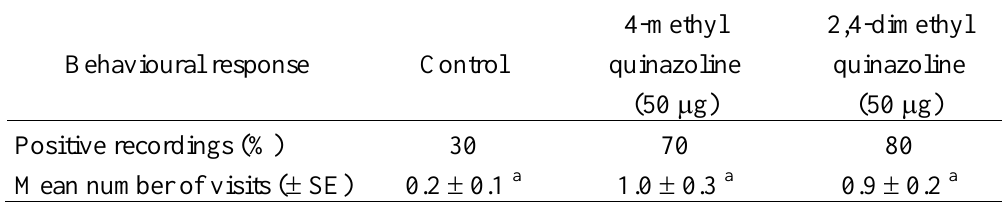
Table 3. Behavioural response of females of T. infestans to 4-methyl quinazoline and 2,4- dimethylquinazoline in an arena